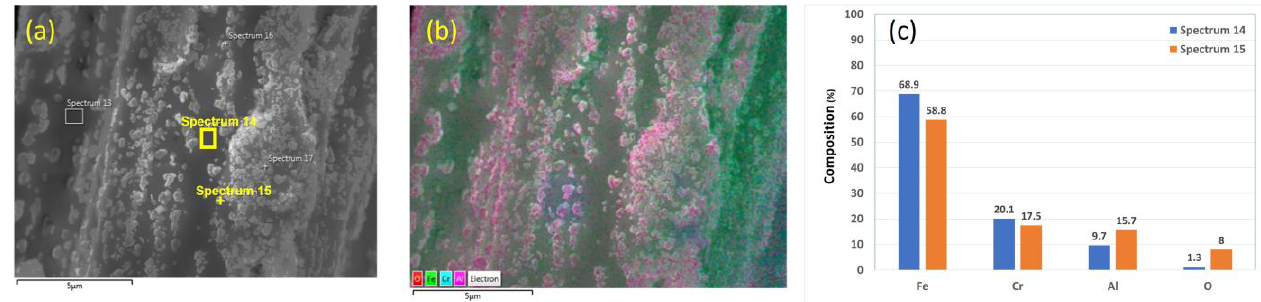
Figure 4. A 12 μm FeCrAl fiber without heat treatment: ( a ) SEM micrograph image, ( b ) EDS layered image, and ( c ) EDS scans of Spectrum 14 and Spectrum 15.